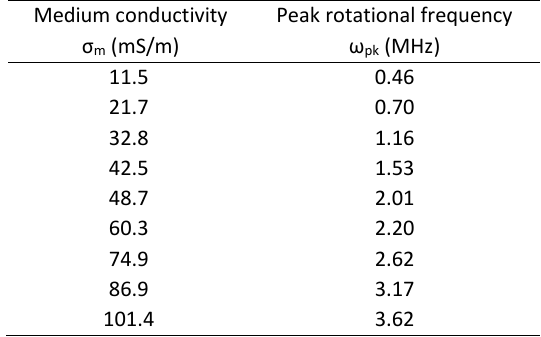
Table 1. Experimental data sets for medium conductivity and peak rotational